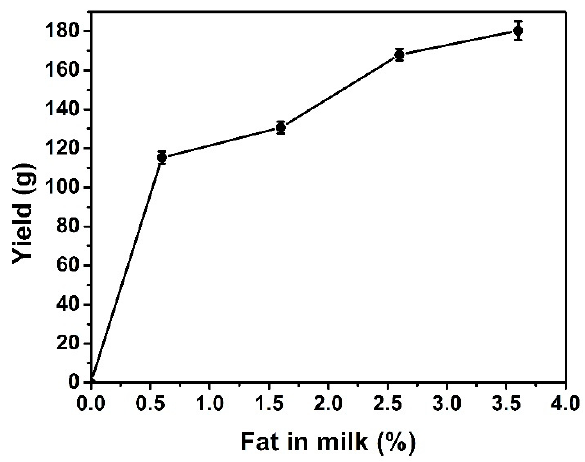
Figure 10. Yield average of Qishta as determined depending on the initial fat concentration in milk (0.6%, 1.6%, 2.6%, and 3.6%). Measurements were made in (0.6%, 1.6%, 2.6%, and 3.6%). Measurements were made in triplicate.